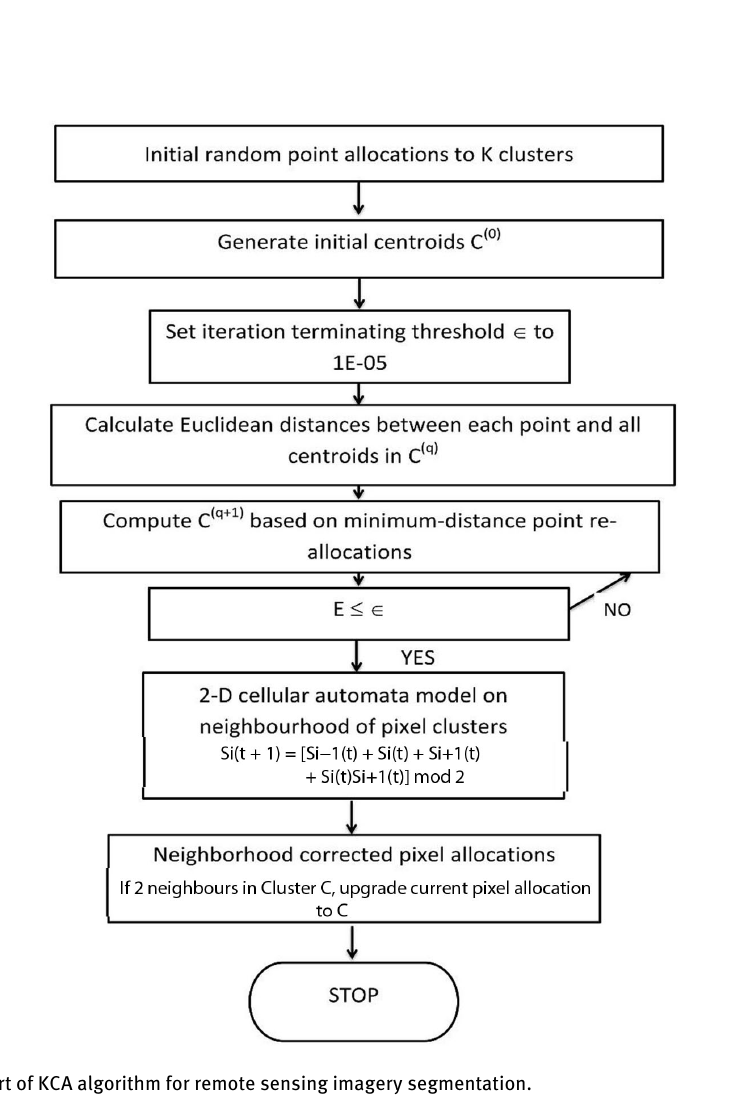
Figure 2: The flowchart of KCA algorithm for remote sensing imagery